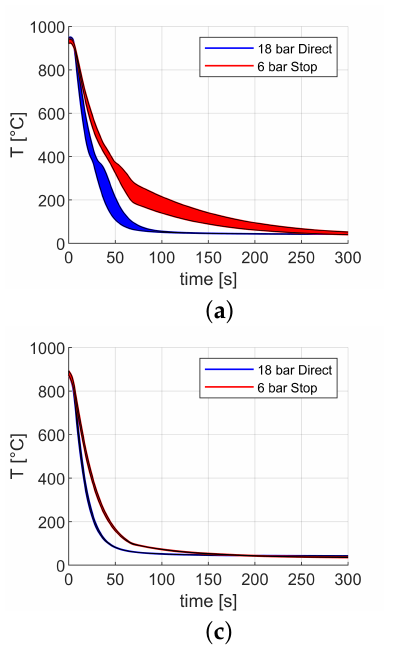
Figure A1. Temperature curves for TCs during HPGQ for 20MnCr5 (A) and 17NiCrMo6-4 (B) at TC positions ( a ) CR, ( b ) root and ( c ) Inconel for 18 bar Direct (blue) and 6 bar Stop